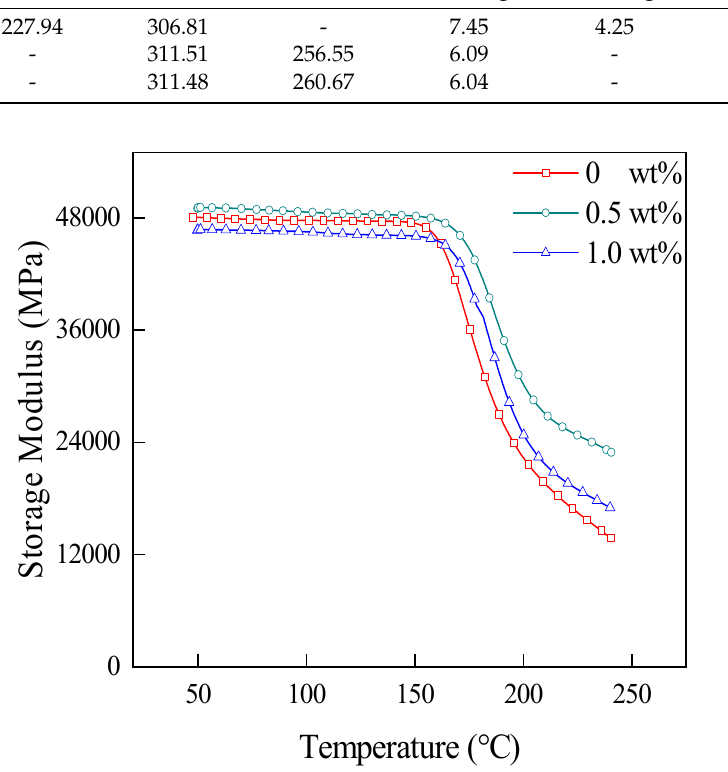
Figure 11. The E ′ -temperature curves of laminates with different CNT contents. Figure 11. The E (cid:48) -temperature curves of laminates with different CNT contents.